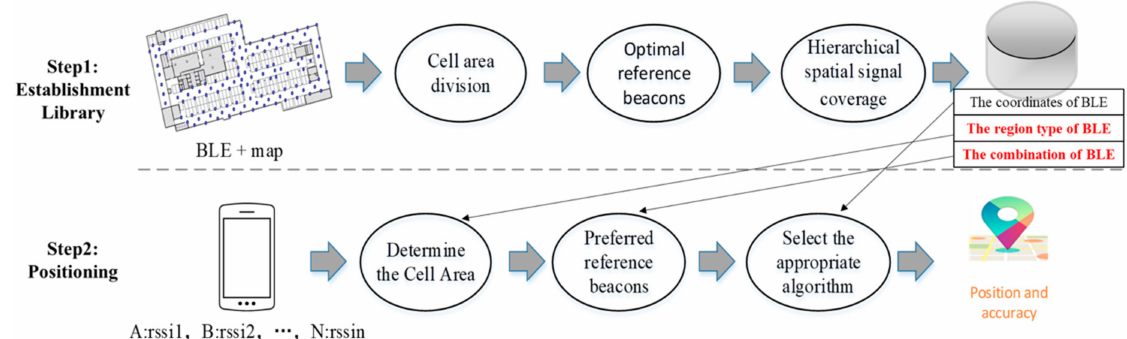
Figure 2. The whole algorithm workflow. The thick arrow is the algorithm flow and the thin arrow indicates the specific information mainly used in the